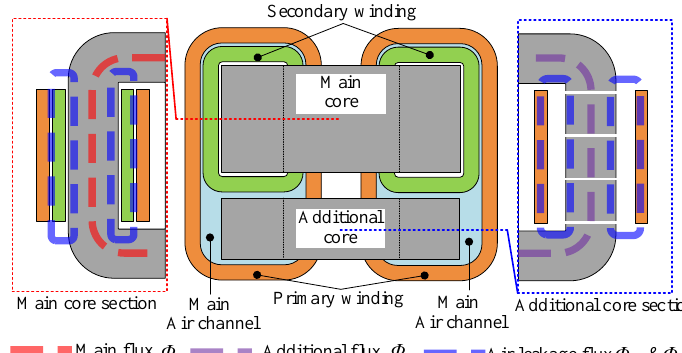
Figure 7. Simplified magnetic field distribution of CW ELII MFT.